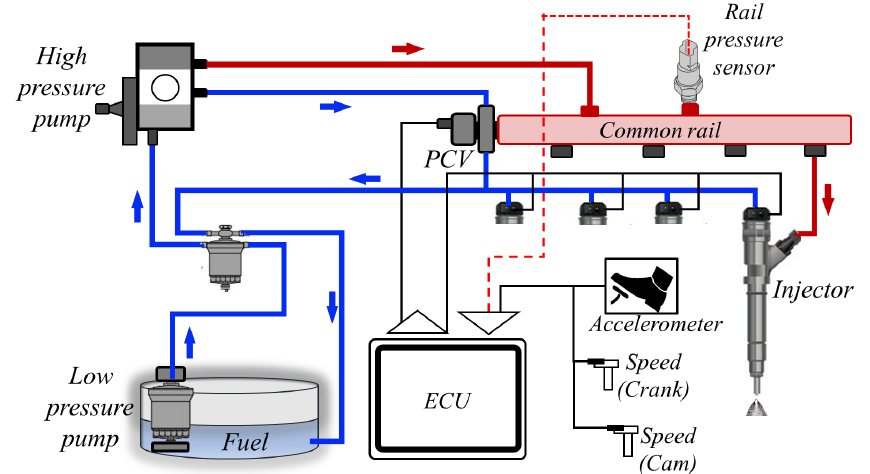
Figure 1. A typical common rail diesel fuel injection